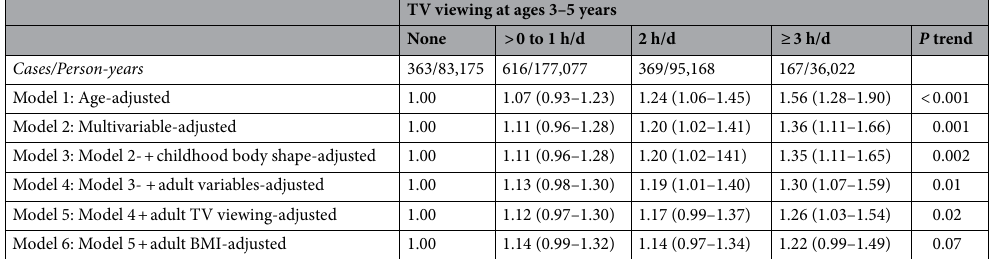
Table 2. Hazard ratios and 95% confidence intervals for adult diabetes incidence by category of television viewing at ages 3–5 years among 34,512 participants of the Nurses’ Health II cohort between 2001 and 2013. TV television. Model 1: adjusted for age of nurse (continuous) and follow-up cycle. Model 2: same as model 1 but with additional adjustment for race (White, Non-White), family history of diabetes (yes, no),